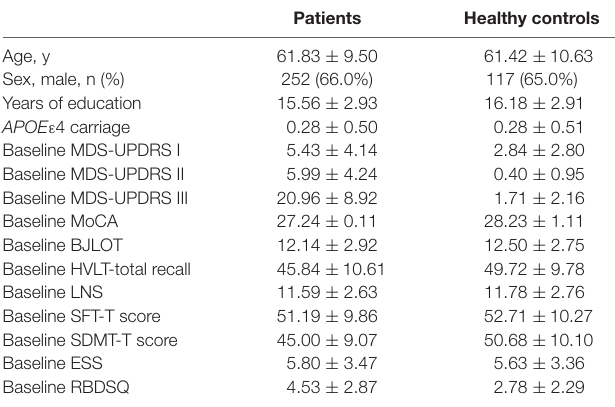
TABLE 1 | Demographic information and clinical characteristics of patients and healthy